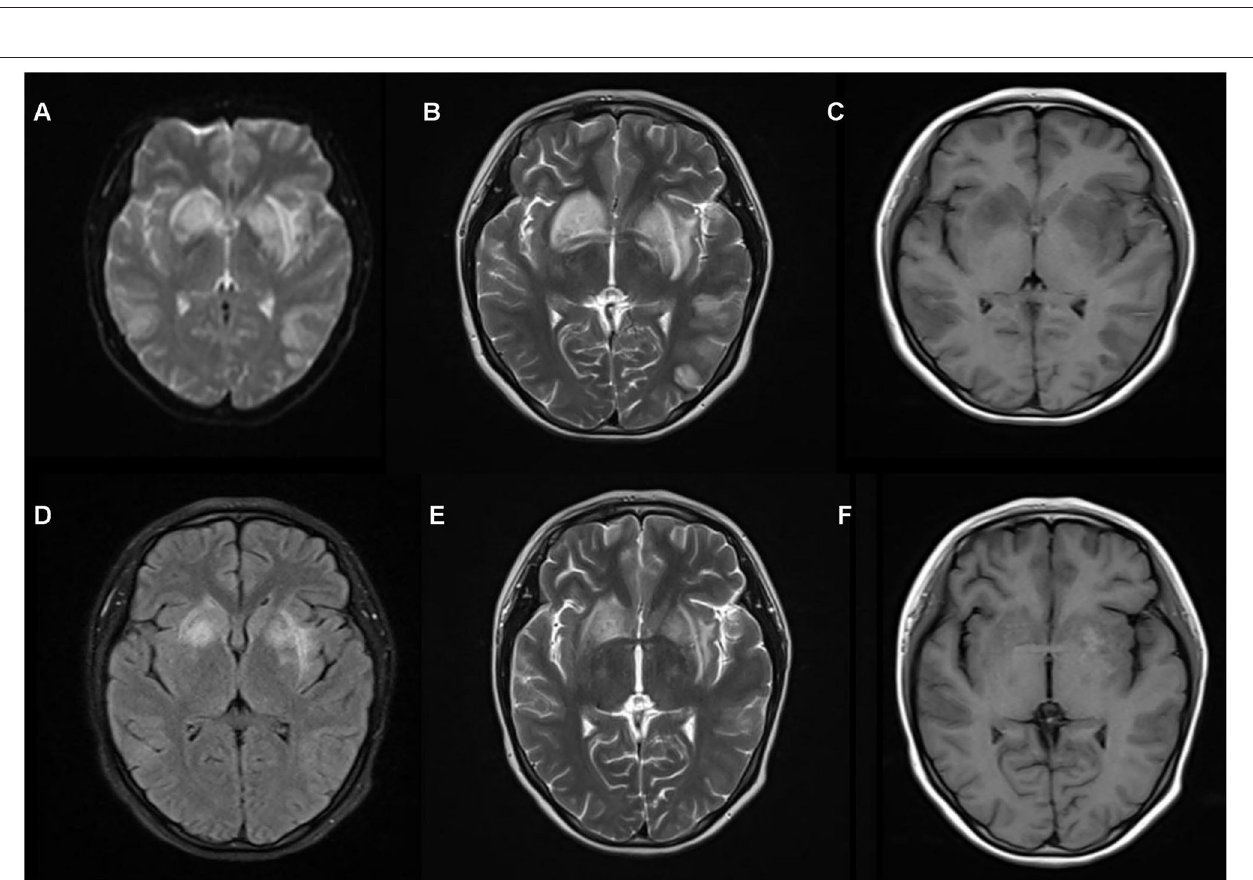
FIGURE 2 | Magnetic resonance imaging (MRI) of case 2 (A–C) shows a wide range of abnormal signals in both hemispheres and basal ganglia region before pulse therapy. Follow-up brain MRI (D–F) after 15 days shows normal results.